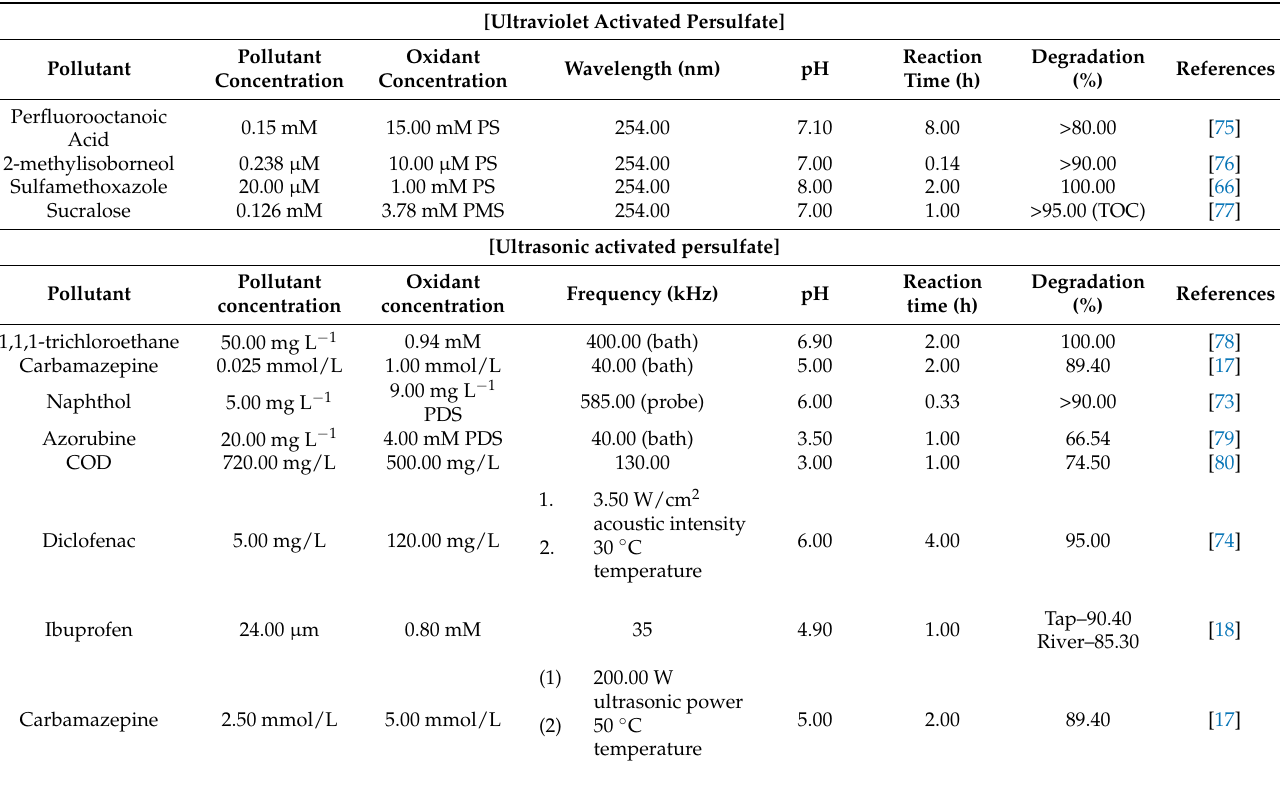
Figure 5. Schematic illustration of ultrasonic/persulfate process (adopted from Monteagudo et al. [74]. Table 3. Ultraviolet and ultrasound activated persulfate for the degradation of ECs.